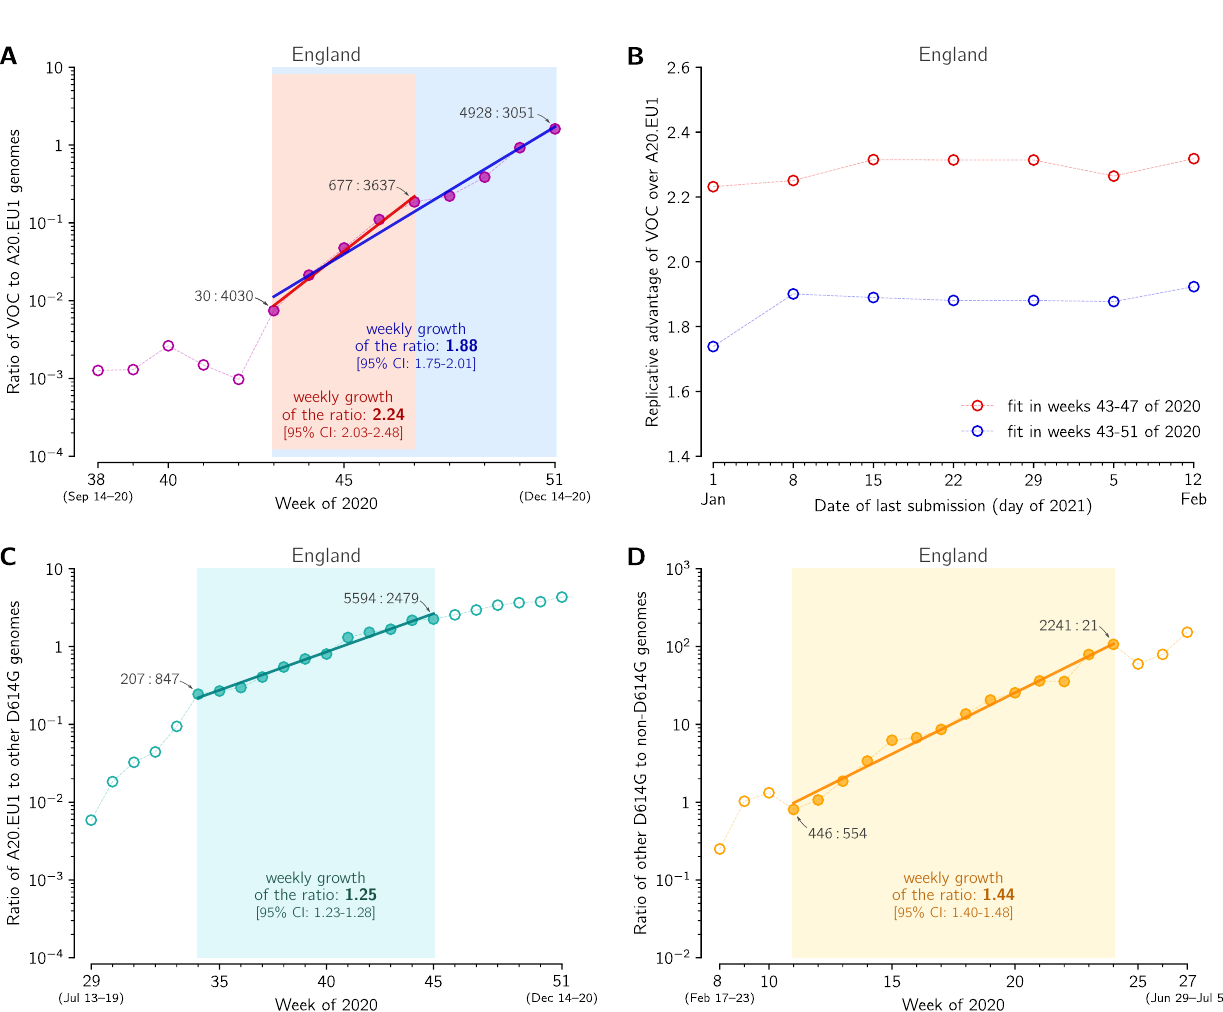
Figure 2. The replicative advantage of the VOC, 20A.EU1, and the D614G strain. ( A ) The ratio of the VOC to 20A.EU1 sequences collected in weeks 38–51 of 2020 in England. The trend line is fitted to data points from weeks 43–51 (blue) and from weeks 43–47 (red). The weekly growth rate is 1.88 [95% CI: 1.75–2.01] for weeks 43–51 and 2.24 [95% CI: 2.03–2.48] for weeks 43–47. ( B ) Stabilization of fits shown in panel A with time-shifting date of the last submission. ( C ) The ratio of the 20A.EU1 to non-20A.EU1 non-VOC D614G genomes collected in weeks 29–51 of 2020 in England. The trend line is fitted to data points from weeks 34–45. The weekly growth rate is 1.25 [95% CI: 1.23–1.28]. ( D ) The ratio of the D614G to D614 genomes collected in weeks 11–27 of 2020 in England. The trend line is fitted to data points from weeks 11–24. The weekly growth rate is 1.44 [95% CI: 1.40–1.48]. Data points for selected weeks are labeled with ratios of the counts of genome sequences. Panels A, C and D are based on GISAID data submitted till 12 February 2021 (provided in Supplementary Data File